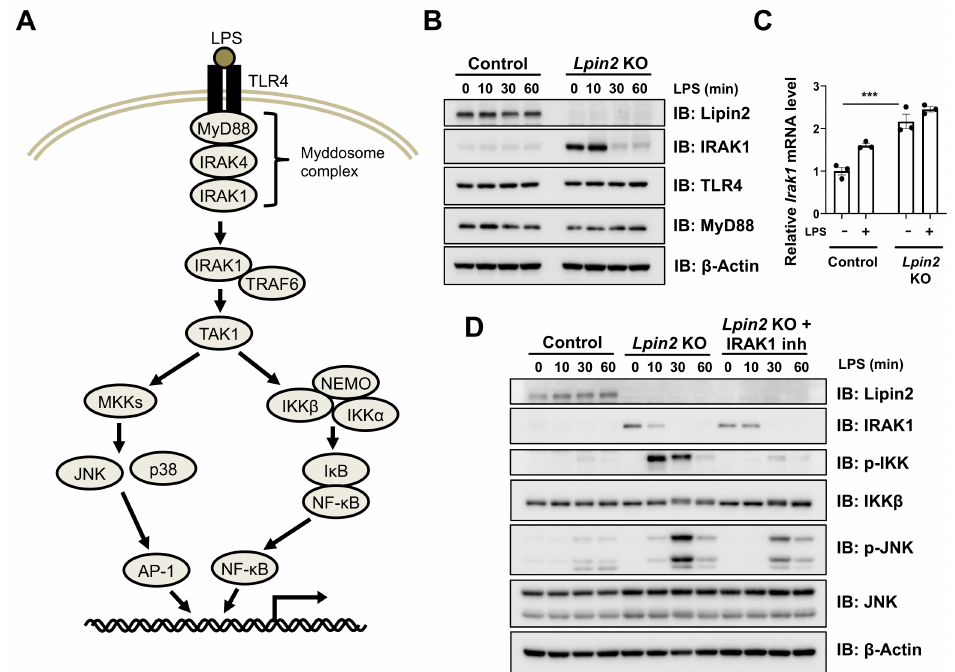
Figure 3. Elevated IRAK signaling induces downstream pathways in Lpin2 knockout RAW-D cells. ( A ) A scheme of the TLR4 signaling pathway. ( B ) IB analysis of WCLs derived from control (WT) and Lpin2 KO RAW-D cells treated with 200 ng/mL LPS. The cells were harvested for IB analysis at the indicated time points. ( C ) RT-PCR was performed to determine relative Irak1 mRNA expression in control and Lpin2 KO RAW-D cells treated with 200 ng/mL LPS for 4 h. Gapdh was used for normalization. Data are means ± SEM ( n = 3). *** P < 0.001, One-way ANOVA followed by multiple comparison test. ( D ) IB analysis of WCLs derived from control and Lpin2 KO RAW-D cells treated with 200 ng/mL LPS. Cells were treated with either DMSO or 10 µ M IRAK inhibitor IRAK1/4 as indicated for 1 h before LPS treatment. The cells were harvested for IB analysis at the indicated time